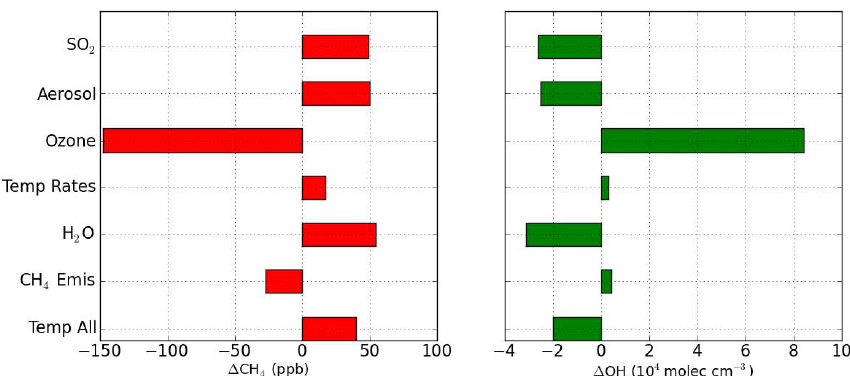
Fig. 5. CH 4 and OH steady-state changes due to various Pinatubo